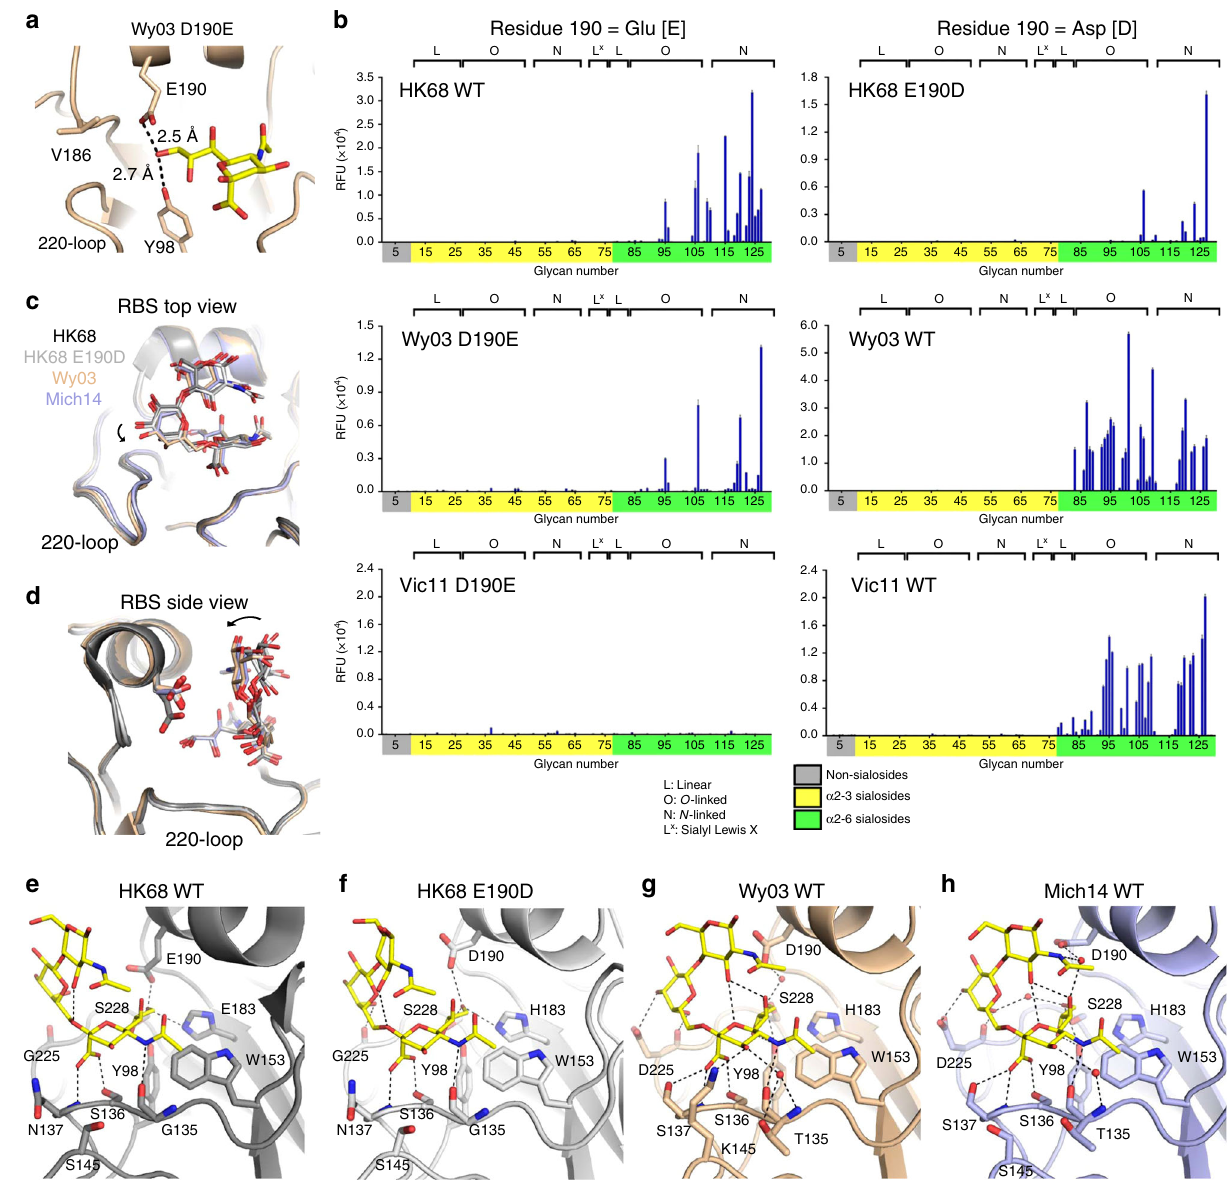
Fig. 5 Positioning of HA residue 190 in different H3 strains. a The interaction between the RBS of Wy03 D190E and sialic acid (yellow sticks) is shown. b 293S-expressed recombinant HA was puri fi ed and analyzed by sialoside glycan array. HAs in the left column carry a Glu at residue 190. HAs in the right column carry an Asp at residue 190. c , d The orientations of human receptor analog 6 ′ -SLN in complex with HK68 WT, HK68 E190D, Wy03 WT, and Mich14 WT are compared. The orientation of 6 ′ -SLN in complex with Wy03 WT and Mich14 deviates from that with HK68 WT and HK68 E190D. This deviation is indicated by the curved arrow. c Top view of the RBS. d Side view of the RBS. e – h The interactions of 6 ′ -SLN (yellow sticks) with e the RBS of HK68 WT (PDB 2YPG 9 ), f the RBS of HK68 E190D, g the RBS of Wy03 WT, and h the RBS of Mich14 WT are shown. Hydrogen bonds are represented